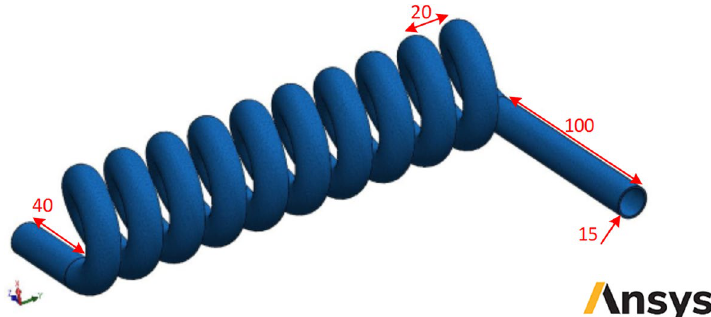
Figure 1. Schematic of studied smooth helical heat exchanger (Images used courtesy of ANSYS,